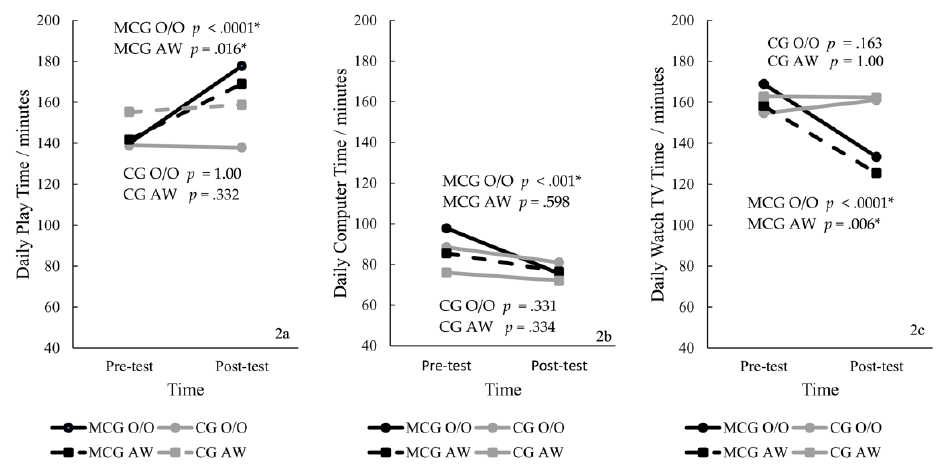
Figure 2. Daily play time ( 2a ), computer time ( 2b ) and watch TV time ( 2c ) by groups (* significant results).